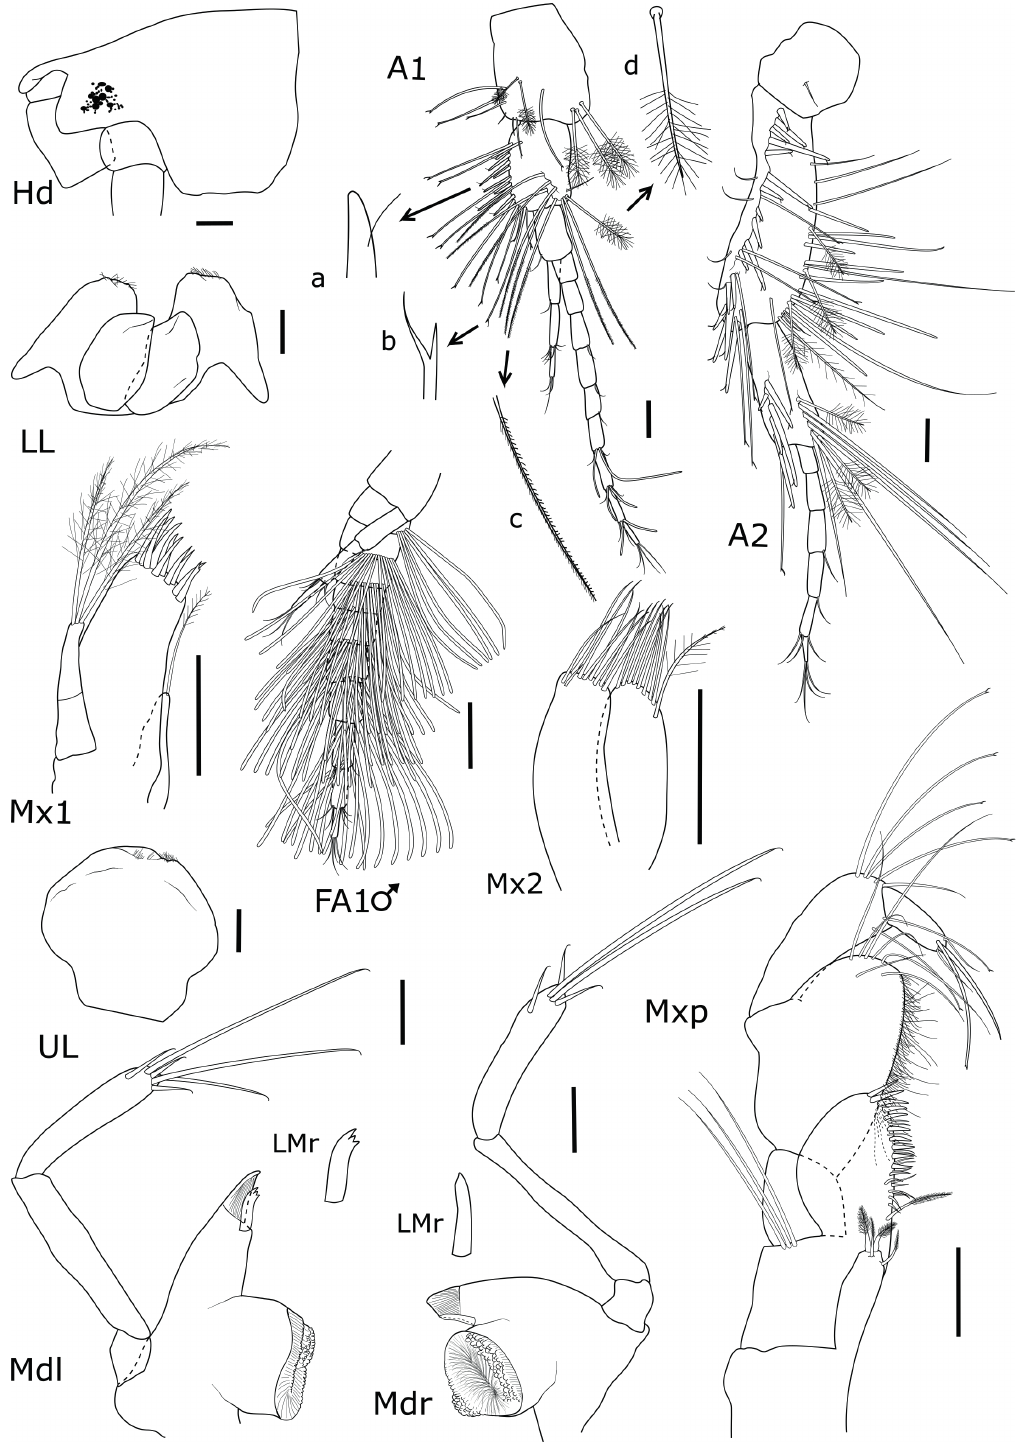
Figure 13 - Puelche mourae sp. nov. Female, 4.0 mm, MNRJ 28795: Head, antennae and mouthparts. Male, 2.7 mm, MNRJ 28796: Flagellum of antenna 1. Detailing of setae of antenna 1: a . robust seta with accessory seta; b . simple seta with lamellate tip; c . plumose seta with small setules; d . penicillate seta. Scales = 0.1